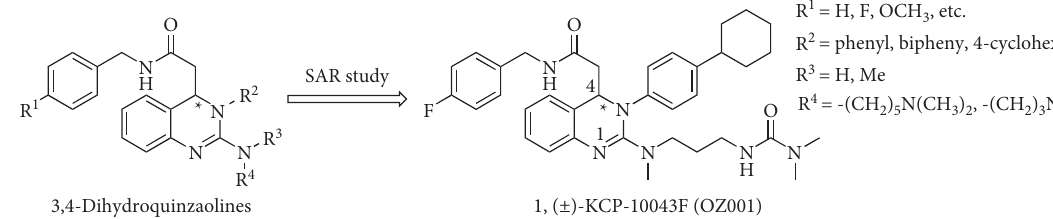
Figure 1: Chemical structures of 3,4-dihydroquinazolines and KCP-10043F ( OZ-001